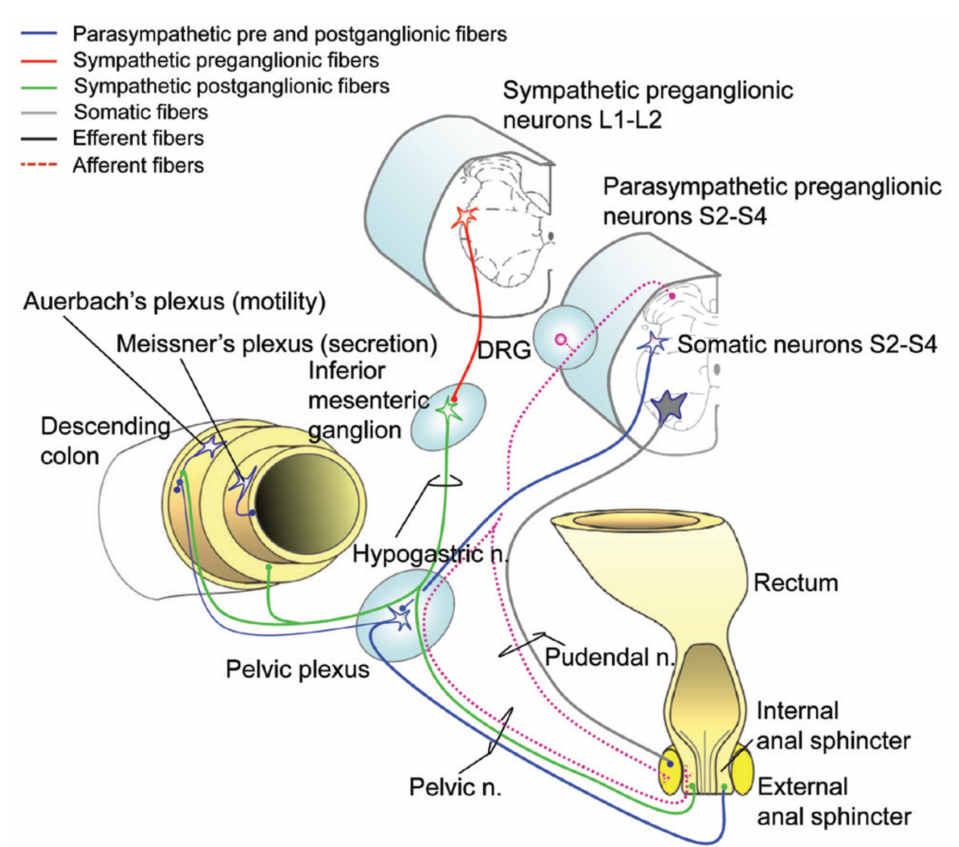
Figure 1. Innervation of the distal gastrointestinal tract. DRG: dorsal root ganglion. Modified by American Spinal Injury Association with permission from Inskip, J.A., et al. Spinal Cord. 2009;47:2- 35 [5]. Reprinted with permission from Ref. [14] Topics in Spinal Cord Injury Rehabilitation, Inter- national Standards to document Autonomic Function following SCI (ISAFSCI). Copyright 2021 by American Spinal Injury